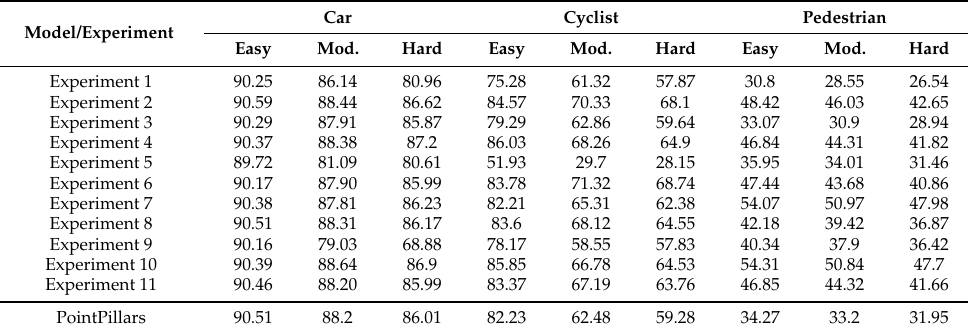
Table 9. Results in validation set for AOS detection